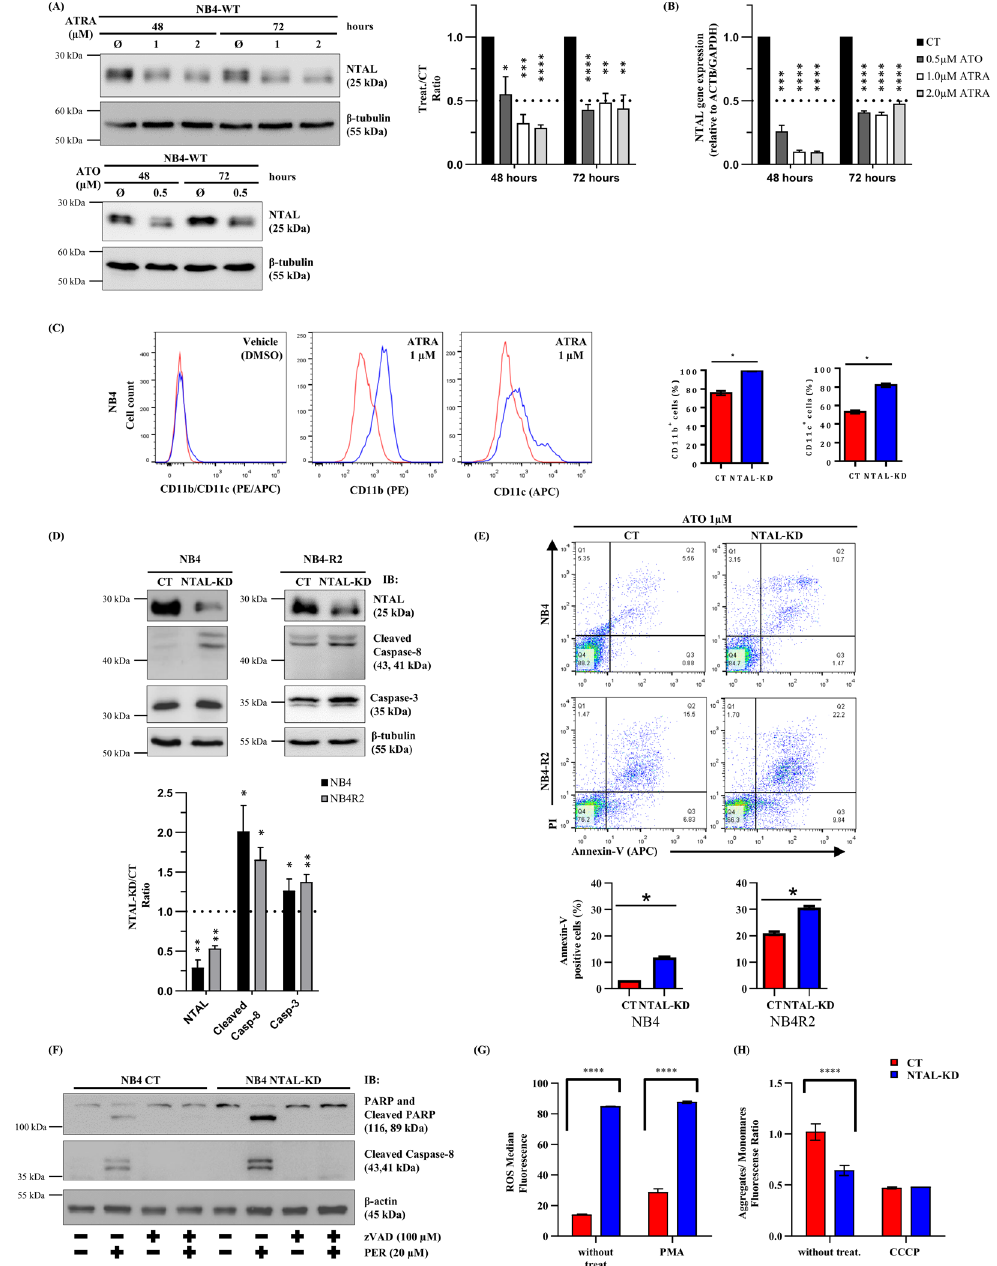
Figure 1. Non-T cell activation linker (NTAL)-knockdown (KD) increases all-trans retinoic acid (ATRA)- induced differentiation, apoptotic molecular markers and ROS activation. ( A ) Protein levels of NTAL after 48 h and 72 h of ATRA (1 or 2 µ M), or arsenic trioxide (ATO) (0.5 µ M) treatment in NB4 wild-type cells. Bar graphs show treatment to control ratio. Values are shown as the mean ± SEM, and ( B ) decreases NTAL mRNA expression levels ( C ) Representative flow cytometry analysis of CD11b and CD11c expression in NB4 cells (CT [control] and NTAL-KD) after 72 h of ATRA (1 µ M) stimulation for differentiation. Bar graphs present the median of positive cells (percentage) analyzed by flow cytometry for cell lines transduced. ( D ) Effect of knockdown of the NTAL protein in NB4 and NB4-R2 cells (CT and NTAL-KD) on apoptotic markers (caspase-3 and caspase-8). Bar graphs show the NTAL-KD to CT ratio. Values are show as the mean ± SEM. ( E ) Effect of knockdown of the NTAL protein in NB4 and NB4-R2 cells (CT and NTAL-KD) on annexin-V + cells at baseline, and following ATO- treatment (1 µ M) for 24 h. ( F ) Analysis of apoptotic markers in NB4 (CT and NTAL-KD) cells pre-treated with 100 μ M zVAD-fmk (zVAD) for 1 h, then treated with 20 μ M perifosine for 6 h. ( G ) General ROS accumulation was evaluated by flow cytometry (2 ′ ,7 ′ -dichlorofluorescein diacetate [H 2 DCFDA] fluorescence). For a positive control, NB4 cells were incubated with PMA (50 nM) to induce ROS accumulation through PKC activation, for 1 h prior to the analysis. ( H ) Δψ (mitochondrial membrane potential) was evaluated using the JC-1 aggregate/JC-1 monomer fluorescence ratio. Values are show as the mean ± SEM ( * P < 0.05; ** P < 0.01; *** P < 0.001; **** P < 0.0001). NB4 and NB4-R2 cell lines were independently analyzed, CT vs.